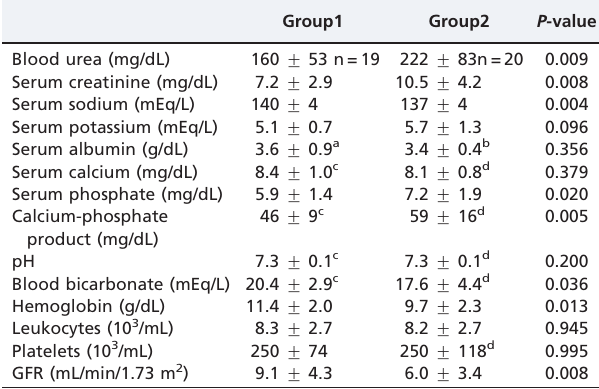
Table 2 - Laboratory parameters of Group1 and